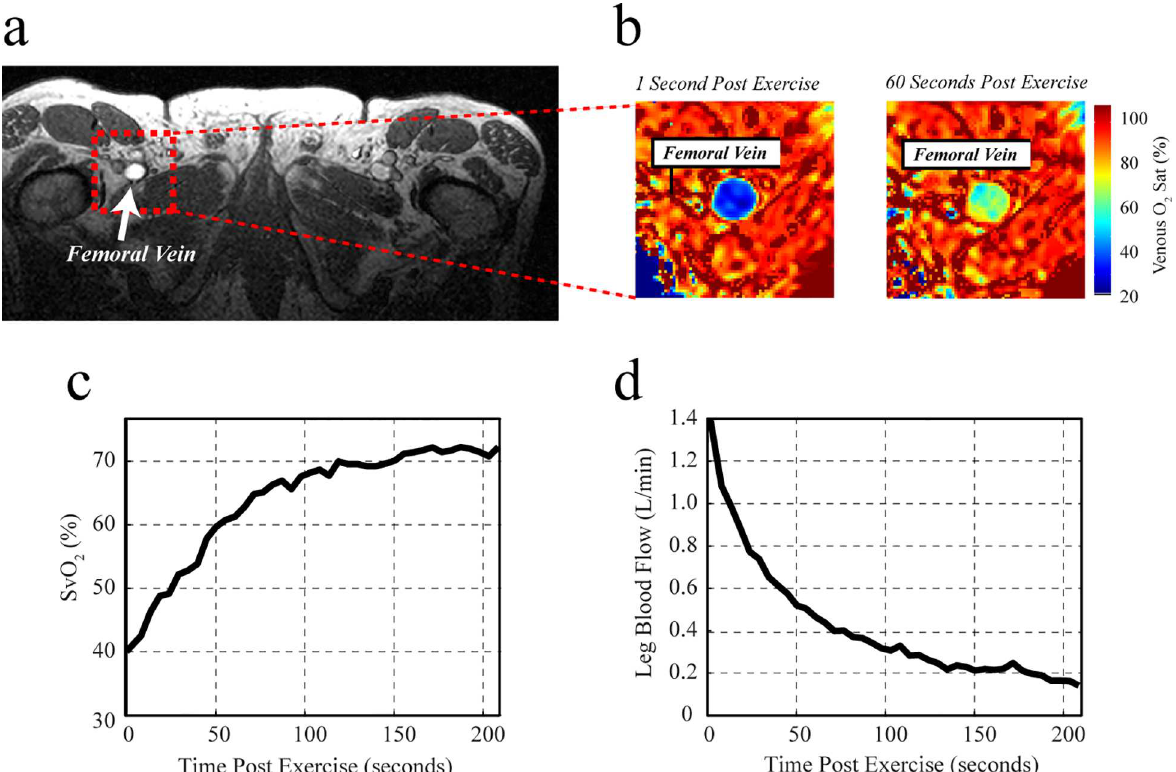
Fig 2. Sample MR images of femoral vein and SvO 2 . ( a ) Anatomic image showingthe slice location for blood flow and venous oxygen saturation imagingexperiments (the targeted right femoral vein is indicated). Sample venous oxygen saturation (SvO 2 ) images at two time points (1 second after end-exercise and 60 seconds after end-exercise) are shown in ( b ), and the corresponding time- course data from this subject for SvO 2 and blood flow, averaged for the entire vein cross-section, are in ( c ) and ( d ), respectively.